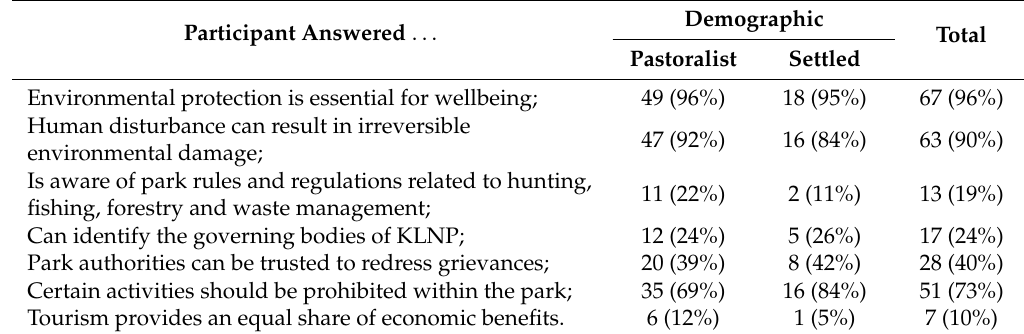
Table 3. Perceptions on conservation and park management activities.